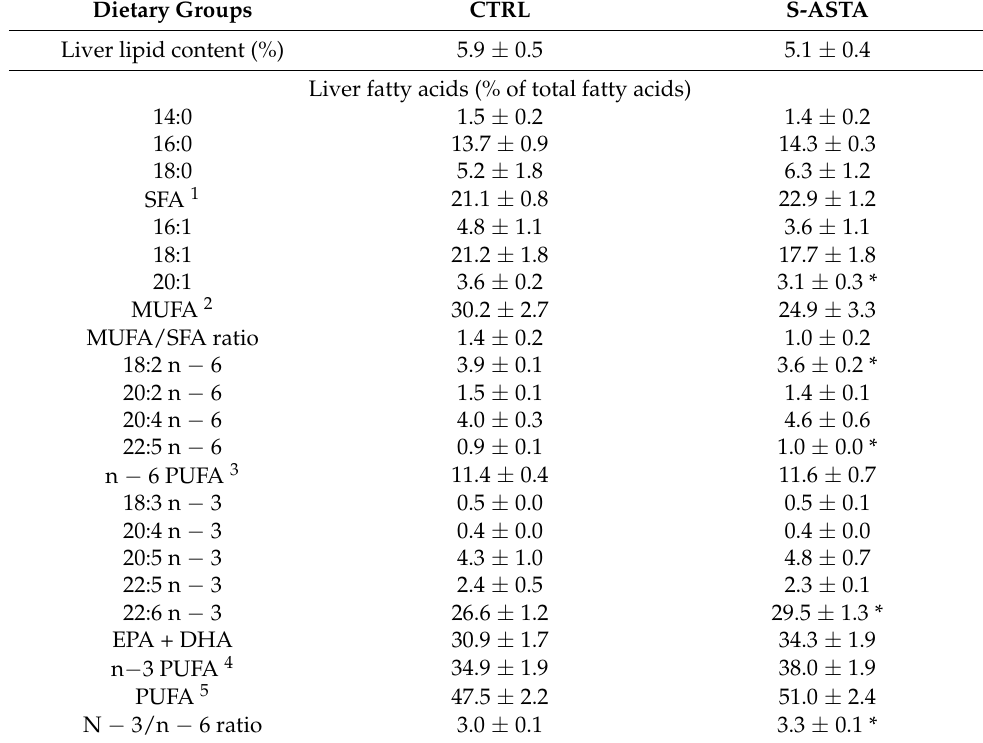
Table 4. Liver lipid content and total lipid fatty acid composition (% of total fatty acids) of rainbow trout fed a diet without (CTRL) and with astaxanthin (S-ASTA) for 12 weeks. Dietary Groups CTRL S-ASTA Liver lipid content (%) 5.9 ± 0.5 Liver fatty acids (% of total fatty